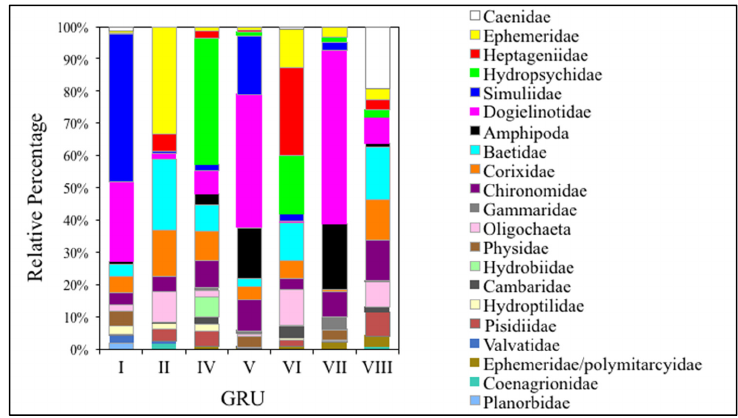
Figure 9. Abundance by relative percentage; the 10 most abundant families in each GRU are included here, with a total of 22 families.